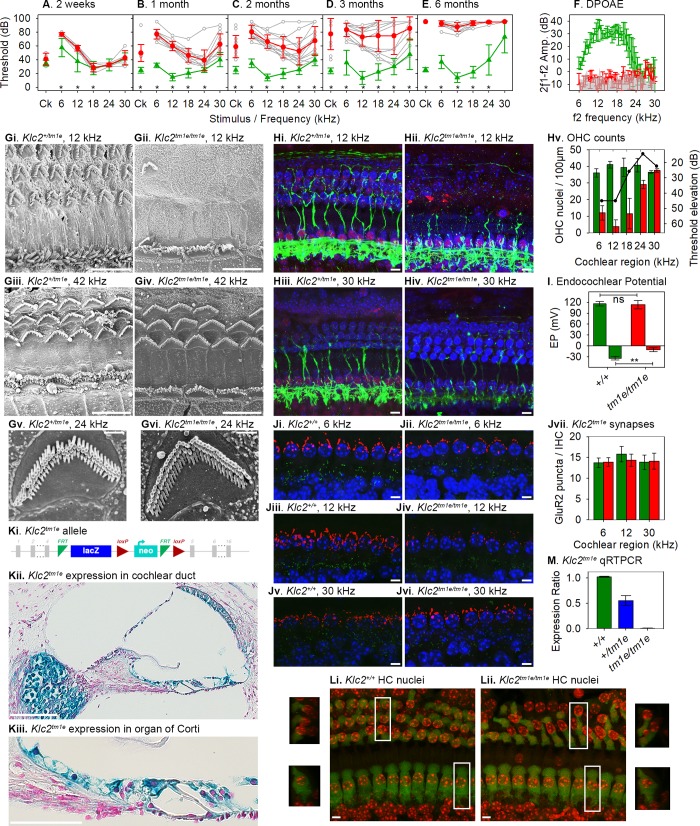
Pathology of the Klc2 mutant.ABR thresholds of Klc2 mutants are close to those of controls at 2 weeks old, and show significant, progressive increases in thresholds from one month onwards, mainly at low frequencies (3–18 kHz), increasing to affect higher frequencies by 6 months old (A-E) (wild types 2 weeks n = 4, 1 month n = 13, 2 months n = 13, 3 months n = 9, 6 months n = 15; Klc2 homozygotes 2 weeks n = 6, 1 month n = 13, 2 months n = 13, 3 months n = 13, 6 months n = 18; Mann–Whitney U test, at 2 weeks old, p = 0.12 overall but p = 0.019 at 3 kHz and p = 0.01 at 6 kHz when testing stimuli separately; p < 0.001 at each later age shown by asterisks). F. DPOAEs at 6 months old show mutant amplitudes (red, n = 3) at the noise floor (grey) across all frequencies tested; wild types (green, n = 3) show normal emission amplitudes. Gi-vi. Scanning electron microscopy revealed extensive loss of OHC hair bundles at P28 in the cochlear regions, corresponding to the worst thresholds in mutants (12 kHz; Gi. heterozygote n = 4, Gii. homozygote n = 11), while there was little sign of hair cell loss at higher-frequency regions (42 kHz; Giii. heterozygote, Giv. homozygote). Remaining hair bundles had a normal appearance (Gv. heterozygote, Gvi. mutant). Scale bars, g-j, 10 μm; k-l, 1 μm. Hi-iv. Confocal imaging at P28 showed that many OHC nuclei were missing in the most affected regions (12 kHz; Hi. heterozygote n = 4, Hii. homozygote n = 5), but most hair cell nuclei were present at less affected regions (30 kHz; Hiii. heterozygote, Hiv. homozygote). Blue, DAPI-labelled nuclei; red, CtBP2-labelled ribbons and IHC nuclei; green, neurofilament-labelled unmyelinated dendrites. Scale bars, 10 μm. Hv. Quantification of OHC nuclei from confocal images demonstrated significant reduction in mutants (red) at best-frequency regions from 6 to 24 kHz and no significant difference with controls (green) at the 30-kHz region. Black line represents ABR threshold elevation in mutants compared with littermate controls. I. EPs in wild types (green) and homozygotes (red) show no significant difference in mutants (homozygotes 113.8 ± 11.5 mV, n = 10; wild-type littermates 116.0 ± 6.5 mV, n = 10; t = 0.518, df = 14, two-tailed p-value = 0.613). Maximum negative potentials during anoxia are significantly reduced in homozygotes (lower part of plot) (homozygotes −10.0 ± 5.39 mV, n = 6; wild-type littermates −33.7 ± 4.8 mV, n = 6; t = −8.050, df = 10, two-tailed p-value = 0.0000111). Ji-vi. Confocal imaging of IHCs at P28 showed no obvious abnormalities of GluR2-labelled postsynaptic densities (green), but less extensive Kcnma1-labelled patches (red) of IHCs in mutants compared with controls at the frequency regions showing the worst thresholds (6 and 12 kHz) (n = 7 homozygotes, 5 littermate controls). Scale bars, 5 μm. Jvii. Counts of green-labelled GluR2 puncta per IHC show no difference between mutants and wild types (6 kHz, homozygotes n = 7, wild types n = 5, t test, p = 0.7422; 12 kHz, homozygotes n = 7, wild types n = 5, t test, p = 0.0737; 30 kHz, homozygotes n = 5, wild types n = 6, t test, p = 0.7089). Ki. Representation of the allele, with exons in grey, FRT sites in green, loxP sites in red, and lacZ and neo components of the inserted construct labelled. Kii-iii. Expression of Klc2 in the cochlear duct of a heterozygote (n = 3) using the LacZ reporter system in the allele. Blue-labelled areas show expression in cells surrounding the cochlear duct and spiral ganglion. Kiii shows a higher magnification of the organ of Corti. Scale bar on Kii, 100 μm, on Kiii, 50 μm. Li-ii. Confocal images of the organ of Corti in a wild type (left) and homozygote (right) at P28 labelled with Myo7a antibody (false-coloured green) showing hair cell bodies and DAPI (false-coloured red) showing nuclei. Small images at left and right show the areas marked in white boxes rotated through 90° around the radial cochlear axis to show a mid-modiolar view of the hair cells. Nuclei appear in similar locations in mutants and controls (base of OHCs, middle of IHCs). Scale bars, 5 μm. M. qRT-PCR of Klc2 mRNA from brain at P28 showed complete knockdown of transcript in homozygotes (red, n = 3); heterozygotes (blue, n = 4) showed around half of the wild-type level (green, n = 2). All plots are means ± standard deviation. Plotted data points are given in S8 Data. ABR, auditory brainstem response; DPOAE, distortion product otoacoustic emission; EP, endocochlear potential; FRT, flippase recombinase target; IHC, inner hair cell; lacZ, gene encoding β-galactosidase; loxP, locus of crossover in P1 bacteriophage; OHC, outer hair cell; P28, postnatal day 28; qRT-PCR, quantitative real-time PCR.